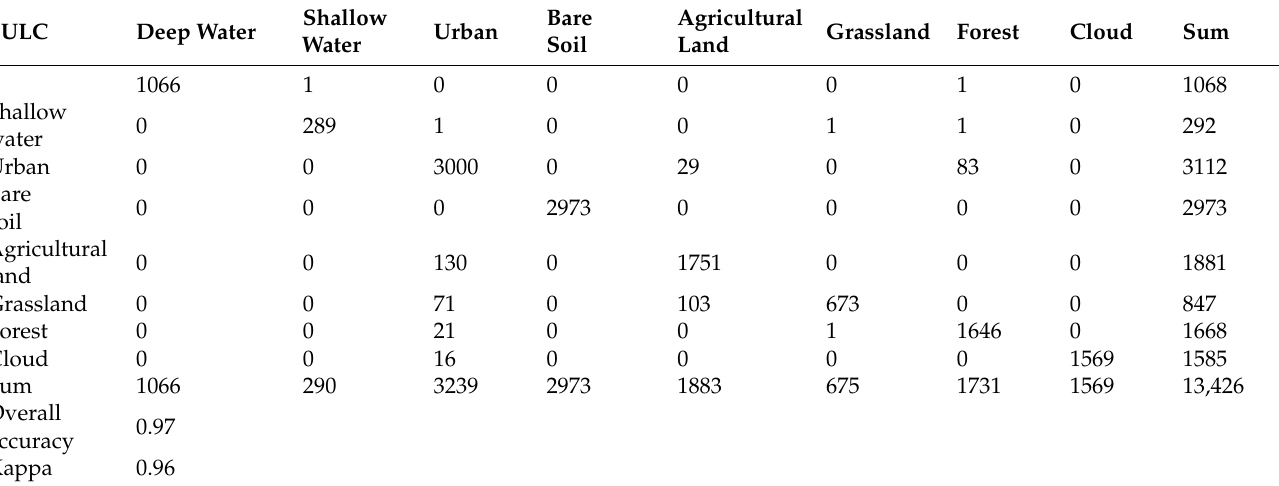
Table 9. Error matrix for accuracy assessment of LULC classification using support vector machine (Leeuwen et al.